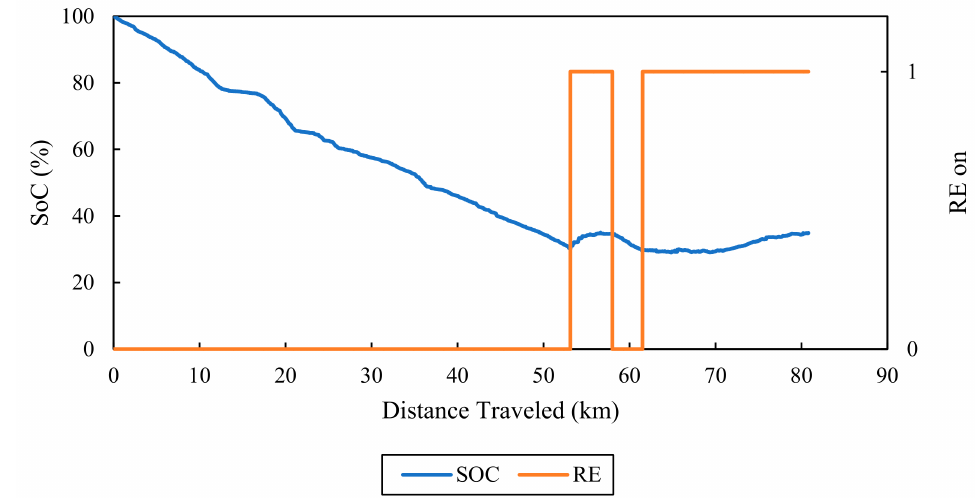
Figure 12. Example of a SoC and RE vs. distance graph of a fully-mechanical NCA 36 kg RE